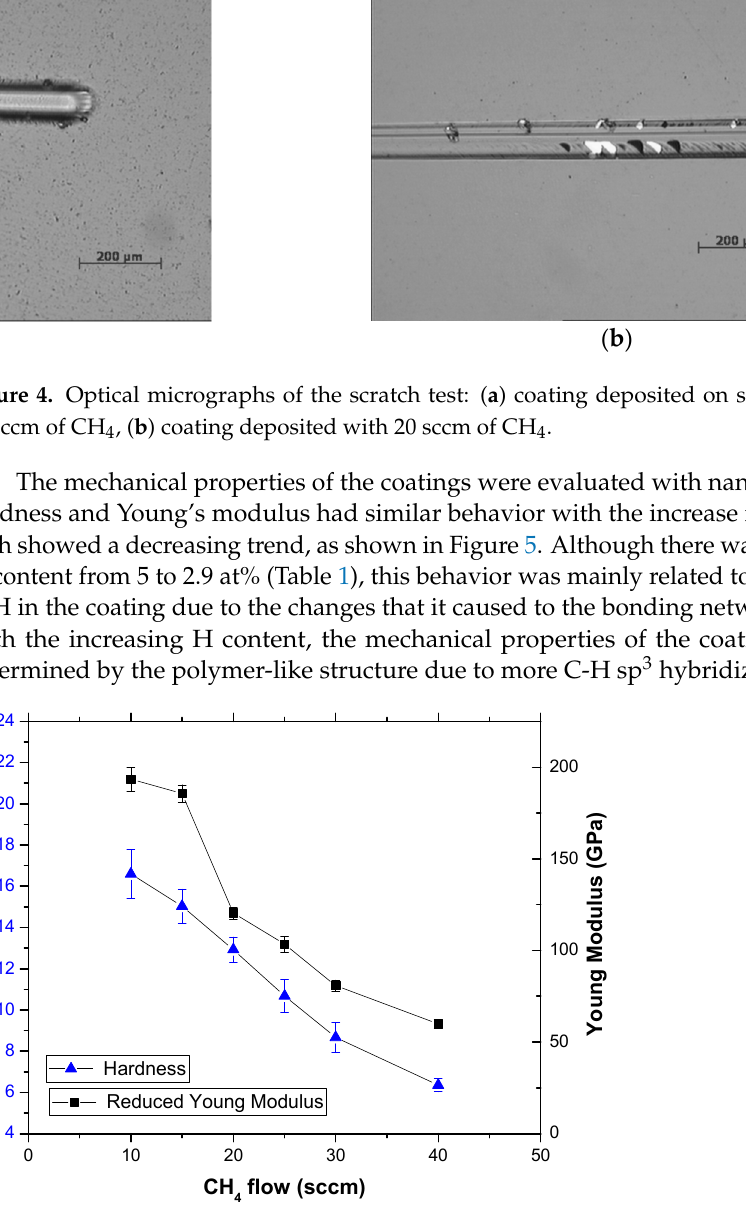
Figure 6. Typical indentation curves for coatings deposited with three different flows of CH 4 . The tribological characterization of the coatings was performed via a pin-on-disc at room conditions with a normal load of 10 N against a 100Cr6 6 mm steel ball. Figure 7a presents the evolution of the friction during the test for the different compositions studied in this work. Two distinct behaviors of the friction can be observed; coatings deposited with up to 20 sccm of CH 4 presented significant fluctuations of the friction during the